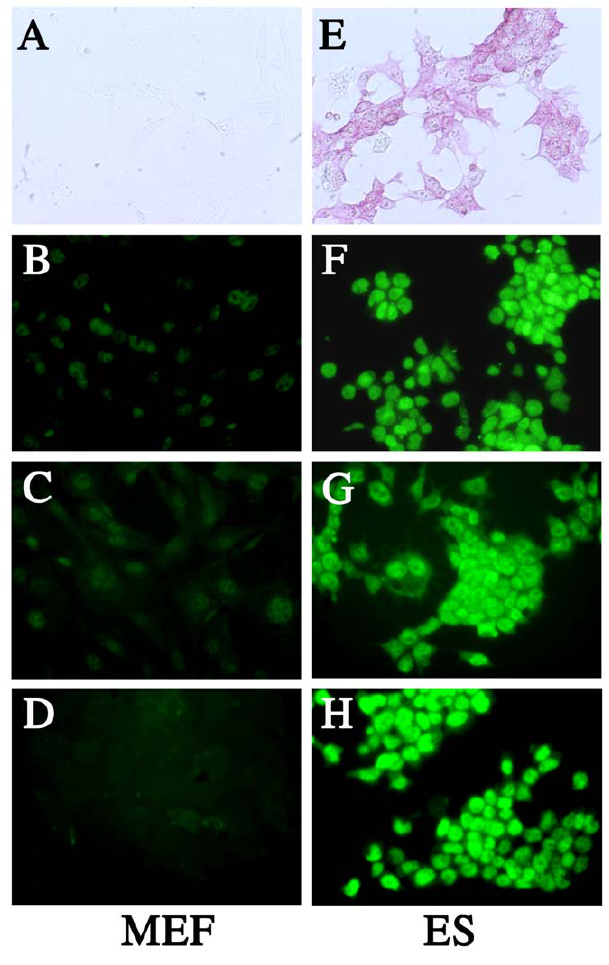
Figure 1. Establishment of ES cell lines. Unlike MEF (A-D), ES cells had alkaline phosphatase activity (E) and expressed SOX2 (F), Nanog2 (G), and OCT3/4 (H).